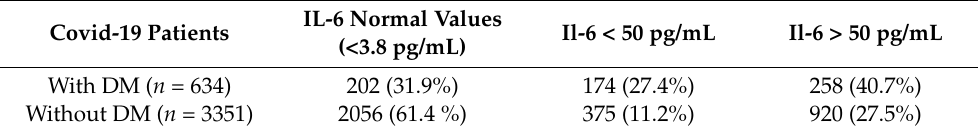
Table 7. Interleukin-6 values in COVID-19